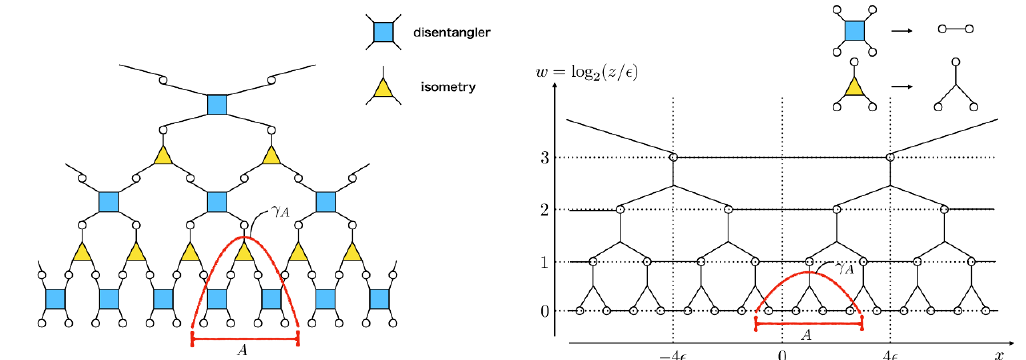
Figure 23 . (Left) A standard description of MERA tensor network. (Right) A simpli(cid:12)ed repre- sentation of MERA. This representation can help us capture the relationship between MERA and AdS. (Both) A is a subsystem of the boundary of MERA, and (cid:13) A is a curve in the bulk who share the boundary with A . ( z; x ) forms a Poincar(cid:19)e coordinate, while w = log number of